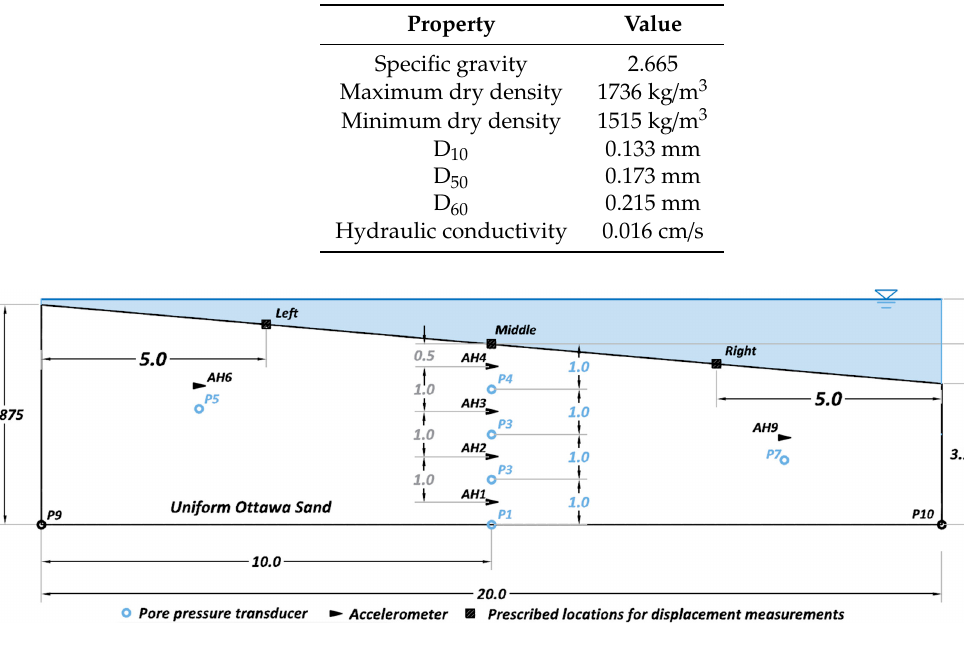
Figure 9. Laminar box container of LEAP centrifuge test (C). All dimensions are in meters (Ziotopoulou (2018) [29]).